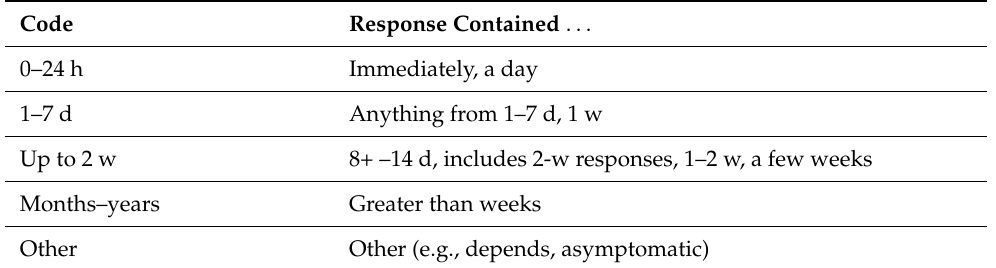
Table A3. Q5 (Time course) “After they first contract the condition, how long do you think it would take for someone to feel symptoms?”.